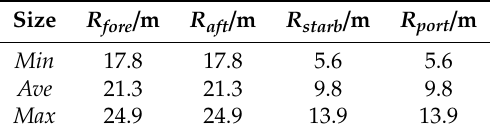
Table 5. Dimensions of the Fujii